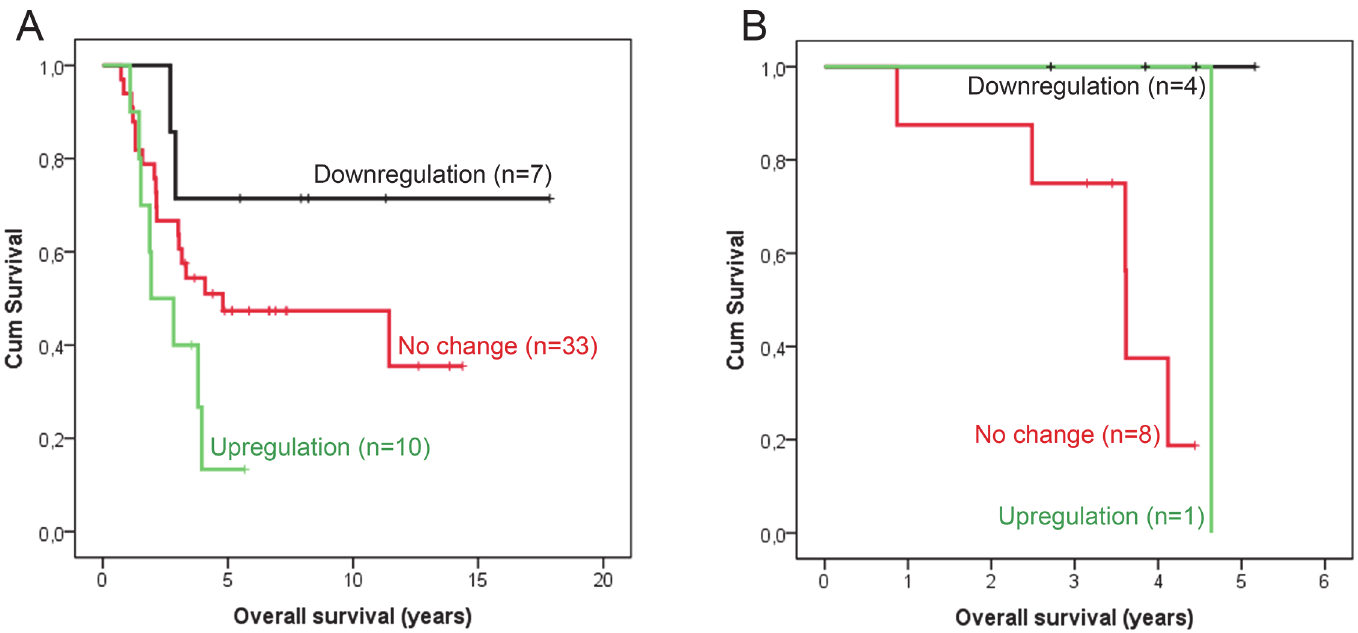
Fig 3. Kaplan-Meier survival curves. Kaplan-Meier survival curve estimates of overall survival of chemotherapy ( A ) or endocrine therapy ( B ) treated patients with a tumor showing a downregulation, no change or an upregulation in IGF-1R expression after neoadjuvant treatment (p = 0.060 and p = 0.069,